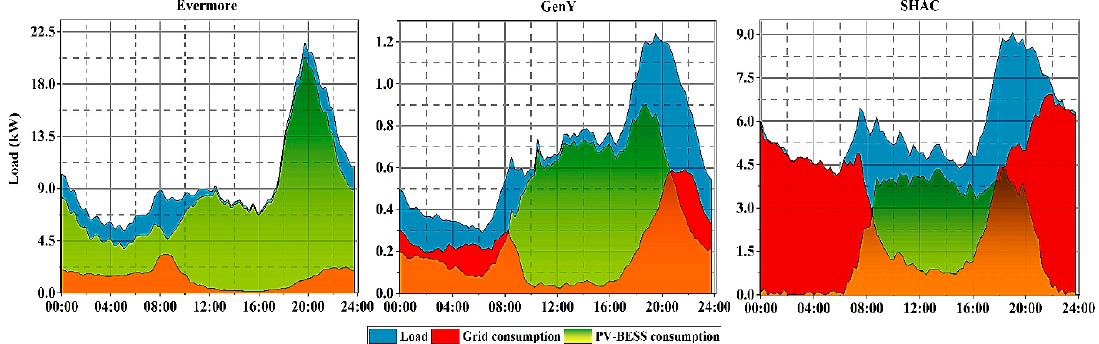
Figure 7. Averaged diurnal load profiles (from left to right; Evermore, Gen Y, and SHAC).